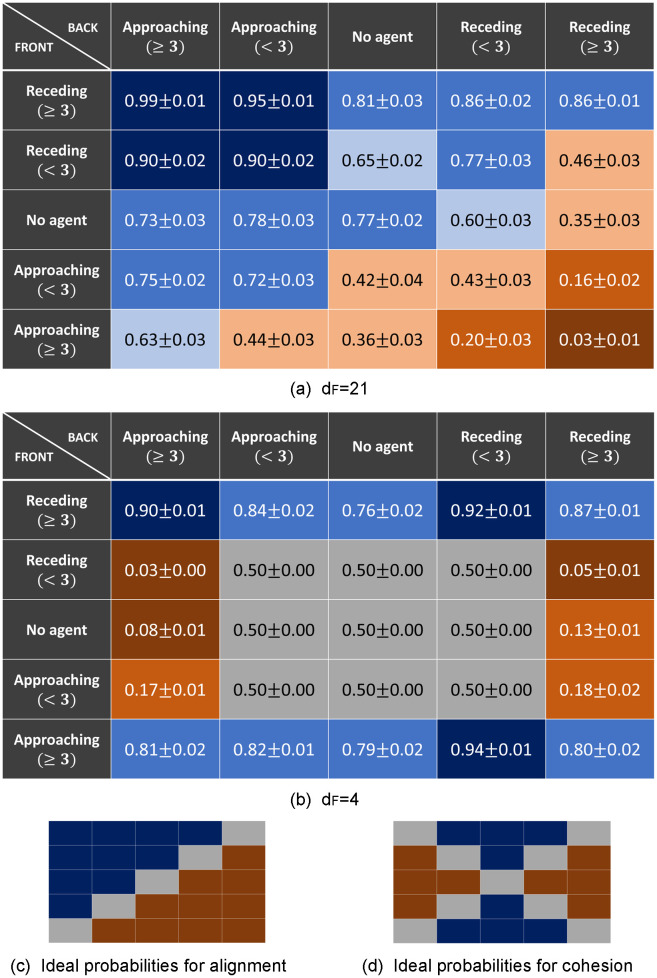
Learned behavior at the end of the training process.The final probabilities in the agents’ ECM for the action “go” are shown for each of the 25 percepts (5x5 table). (a) and (b) Final probabilities learned in the scenarios with dF = 21 and dF = 4 respectively. The average is taken over 20 ensembles (each learning task) of 60 agents each. Background colors are given to easily identify the learned behavior, where blue denotes that the preferred action for that percept is “go” and orange denotes that it is “turn”. More specifically, the darker the color is, the higher the probability for that action, ranging from grey (p ≃ 0.5), light (0.5 < p < 0.7) and normal (0.7 ≤ p < 0.9) to dark (p ≥ 0.9). Figures (c) and (d) show what the tables would look like if the behavior is purely based on alignment (agent aligns to its neighbors with probability 1) or cohesion (agent goes towards the region with higher density of neighbors with probability 1), respectively. See text for details.